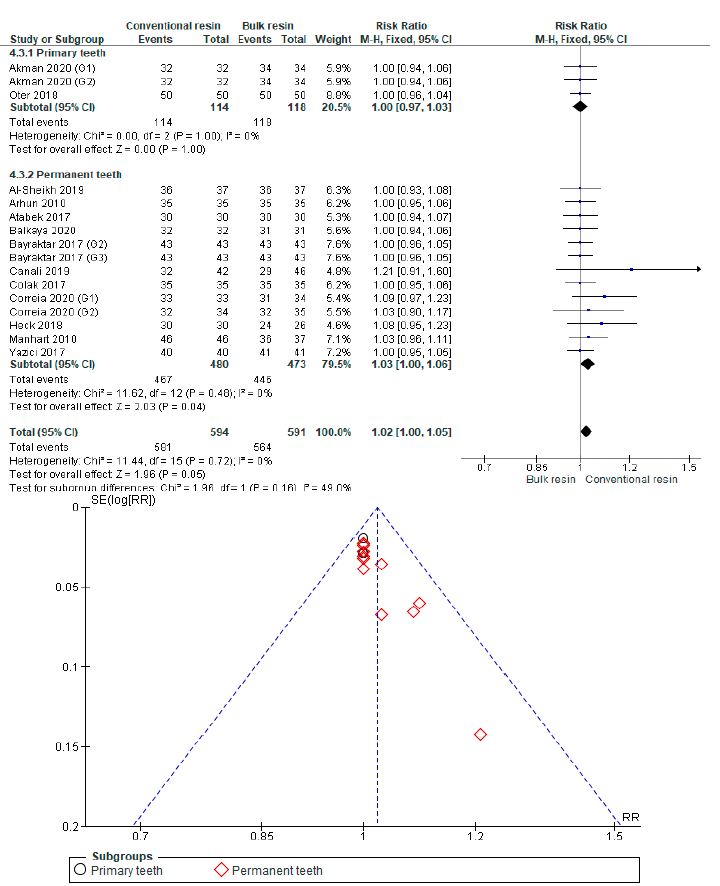
Figure A18. Absence of Post-Operative Sensitivity: Conventional Resin versus Bulk Resin According to Type of Teething.